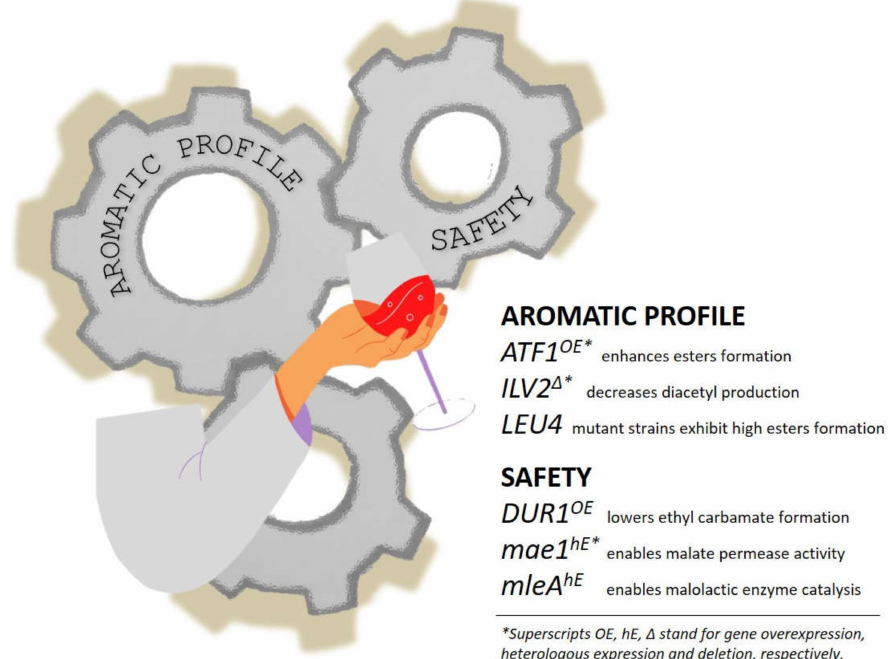
Figure 6. Grind the gears of wine and beer yeasts. The complexity of the aromatic profile can be improved i.e., by disrupting the α -acetohydroxyacid synthase gene ILV2 with the decrease of diacetyl production (“butter flavour”) or enhancing isoamyl acetate flavor production (“banana flavour”) by overexpressing the alcohol-acetyl transferases encoded by ATF1 or mutated LEU4 , key-role enzymes